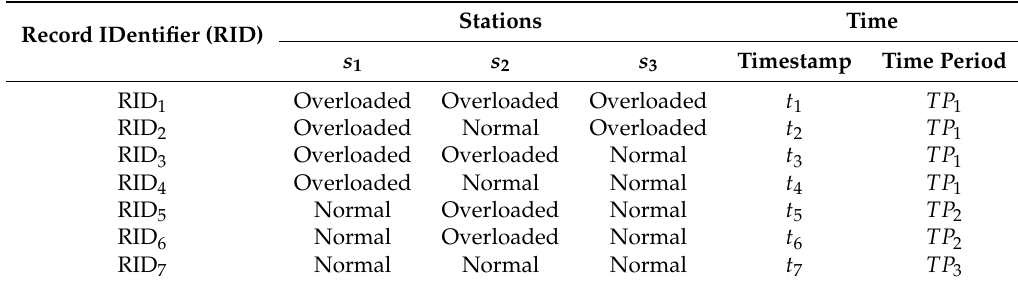
Table 1. Example of Occupancy level